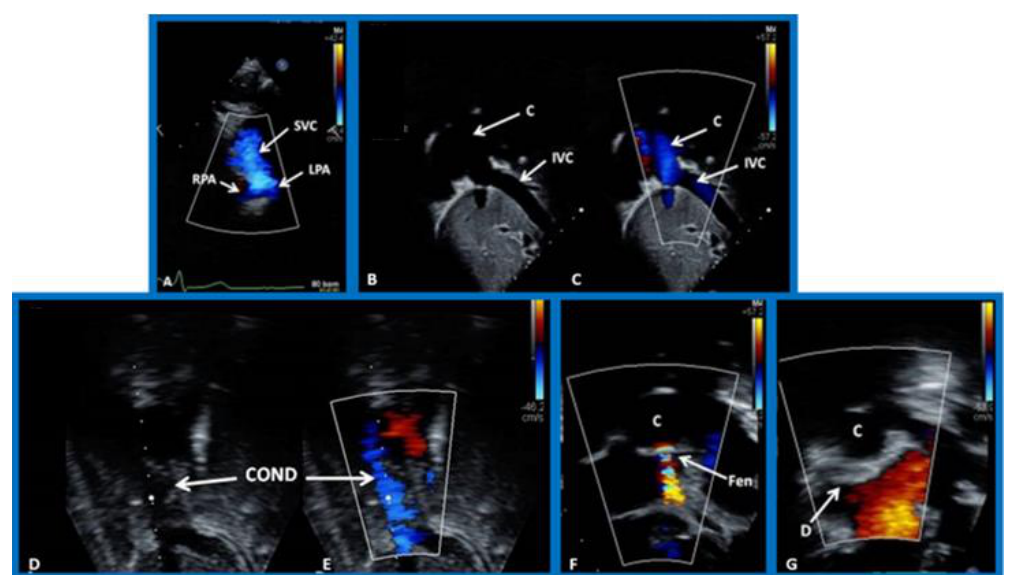
Figure 13. ( A ). Selected video images from suprasternal notch view demonstrating bidirectional Glenn shunt. The superior vena cava (SVC) is seen to empty into the right (RPA) and left (LPA) pulmonary arteries by color flow Doppler. ( B , C ). Selected video frames demonstrating connection between the inferior vena cava (IVC) and the conduit ( C ) by two-dimensional ( B ) and color flow Doppler ( C ). The IVC–C junction is widely patent. ( D , E ). Selected video frames demonstrating a patent conduit (COND) by two-dimensional ( D ) and color flow Doppler ( E ). Laminar flow as seen in ( E ) indicates that there no obstruction within the COND. ( F ). Selected video frames from an apical four chamber view by two-dimensional and color flow Doppler ( F ) illustrating a cross-sectional view of the C and fenestration (Fen). Turbulent flow is seen across Fen. ( G ). Selected video frame from apical four chamber view showing the position of the Amplatzer device ( D ) (arrow in ( G )). No residual shunt is demonstrated. Modified from [38].